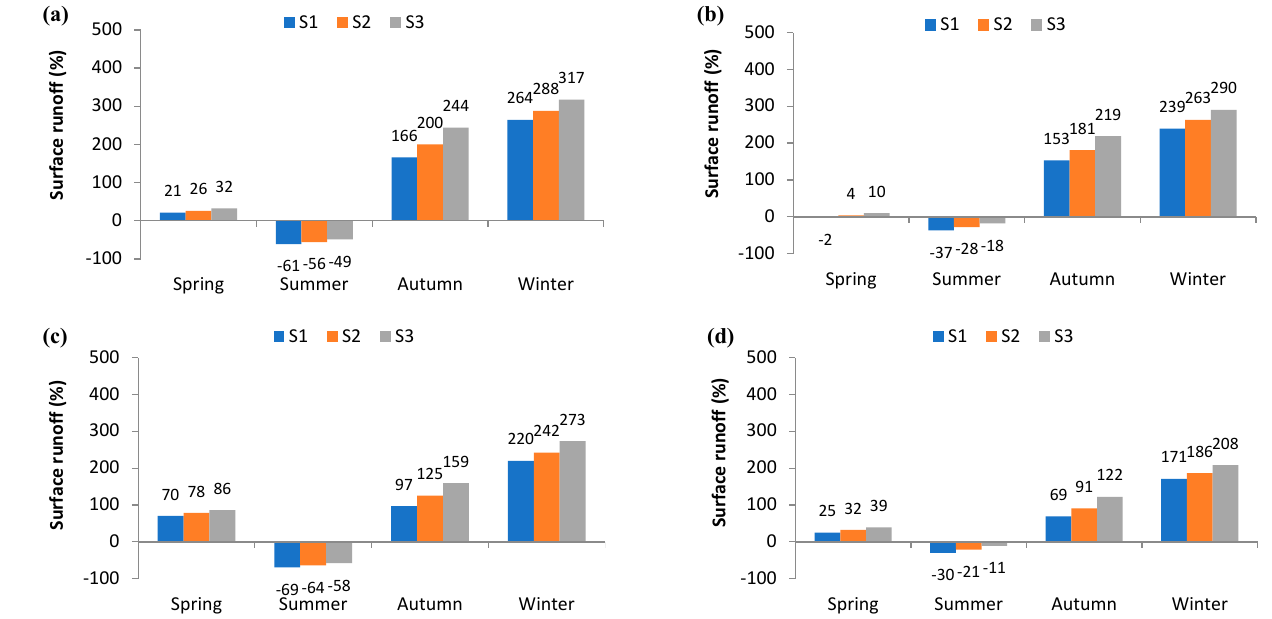
Figure 8. Seasonal surface runoff (%) projected for 2020–2039 in: ( a ) REMO4.5, ( b ) CLM4.5, ( c ) REMO8.5, and ( d ) CLM8.5.